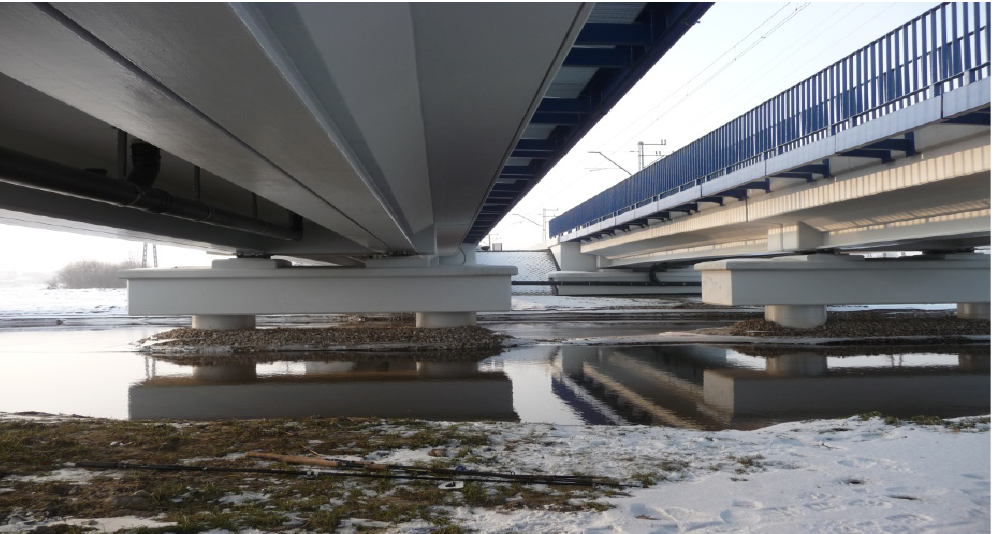
Figure 36: Bottom view of “Wierna Rzeka”